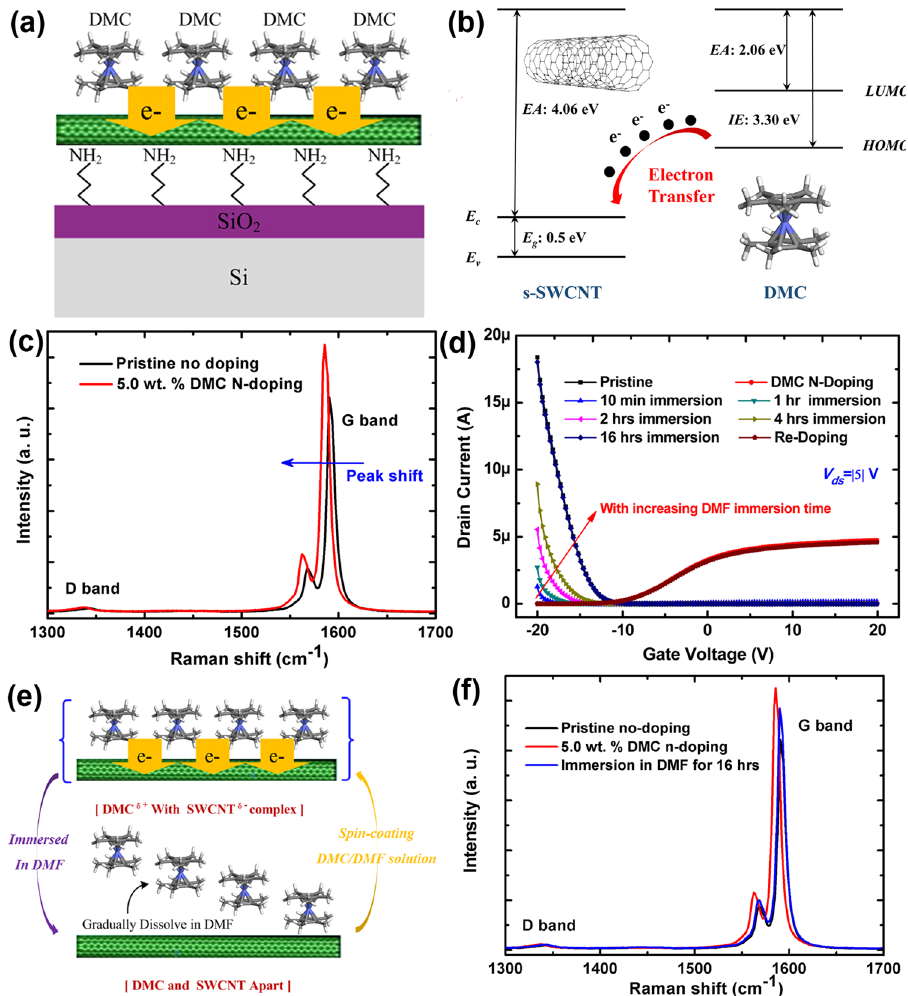
Figure 4. ( a ) The schematic illustration of our proposed DMC based surface charge doping process. ( b ) The energy band diagrams of s-SWCNT and DMC redox states showing the electron transfer process from higher electron energy level material (DMC) to lower materials (s-SWCNTs) which gives rise to n-type doping induced by surface charge transfer. ( c ) The Raman spectrum of pristine nanotube networks before any doping process and that after 5.0 wt. % DMC n-doping where the observed G-peak downshift indicates the effective n-type doping effects induced by surface charge transfer process. ( d ) Transfer characteristics of a CNFET device before any doping process, after DMC doping, after immersion in DMF for different periods of time and after re-doping process to depict the reversible properties of DMC n-type doping on nanotubes. ( e ) The schematic illustration of the desorption/adsorption process of DMC molecules from/onto the nanotube surface through immersion in DMF solvent or by spin-coating DMC/DMF solution, respectively. ( f ) Raman spectra of nanotubes before any doping process, after DMC doping and after immersion in DMF for 16 hours, indicating the reversibility of DMC doping process and almost no induced structural